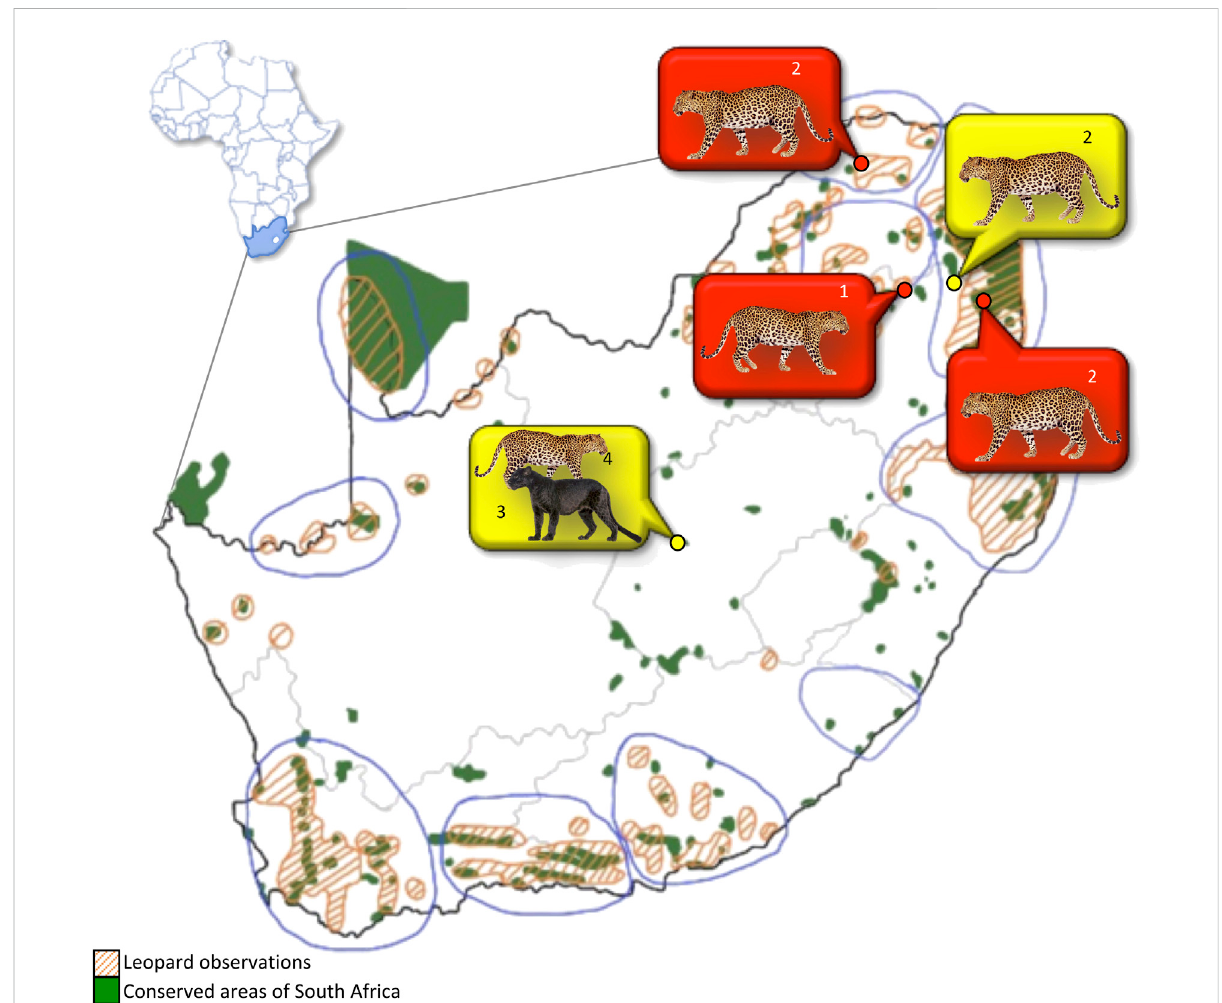
FIGURE 1 TencoreSouthAfricanleopardpopulations(bluelinedareas)inrelationtoformallyconservedareas.Samplinglocationsindicatedbyyellowand red dots. Orange striped polygons: areas of leopard observations; Green polygons: conserved areas; Yellow bubble: captive leopards; Red bubble: wild leopards. Numbers indicate the number of individual leopards sampled at each